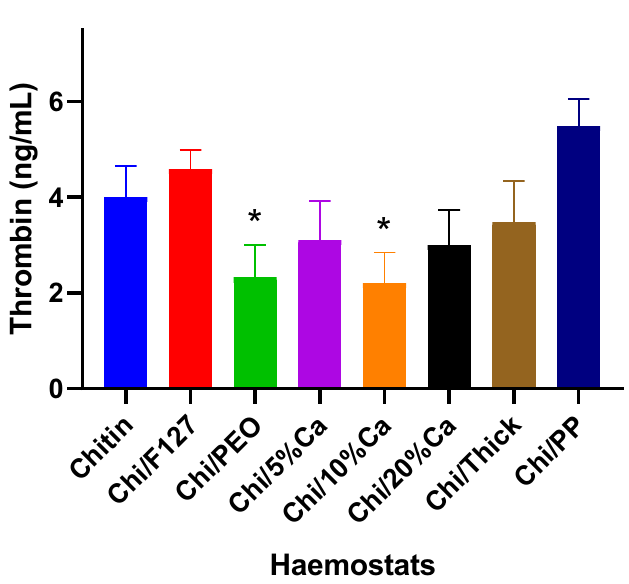
Figure 7. The effect of chemical and structural modification on the thrombin generating ability of the beta- chitin patch, as measured by thrombin–antithrombin assay (ng/mL). *p < 0.05 compared to non-modified beta- chitin patch, analysed by Kruskal–Wallis one-way ANOVA with Dunn’s test, n =